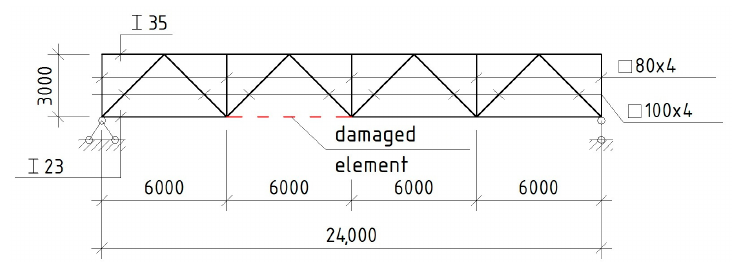
Figure 9. Truss with a span of 24 m and a damaged lower chord.